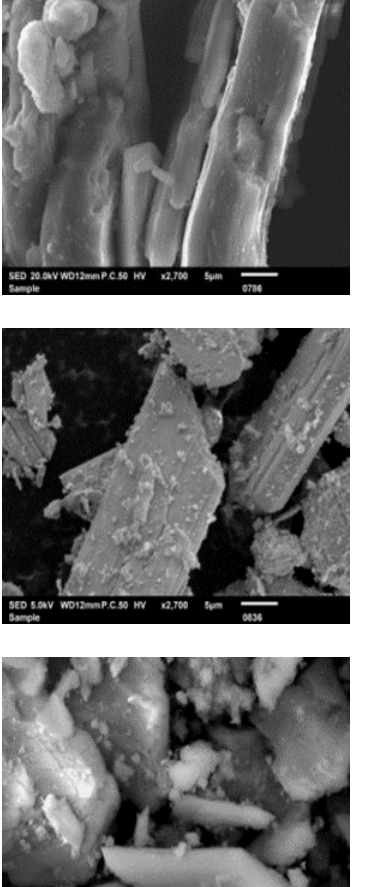
Figure 5. Nitrogen adsorption/desorption isotherms and the pore distribution of the PGT and PGM samples.